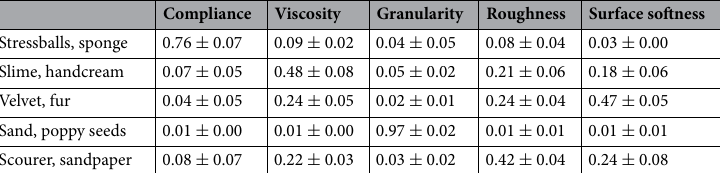
Table 2. Mean posterior probabilities and standard deviations from the classification analysis as shown in Fig.